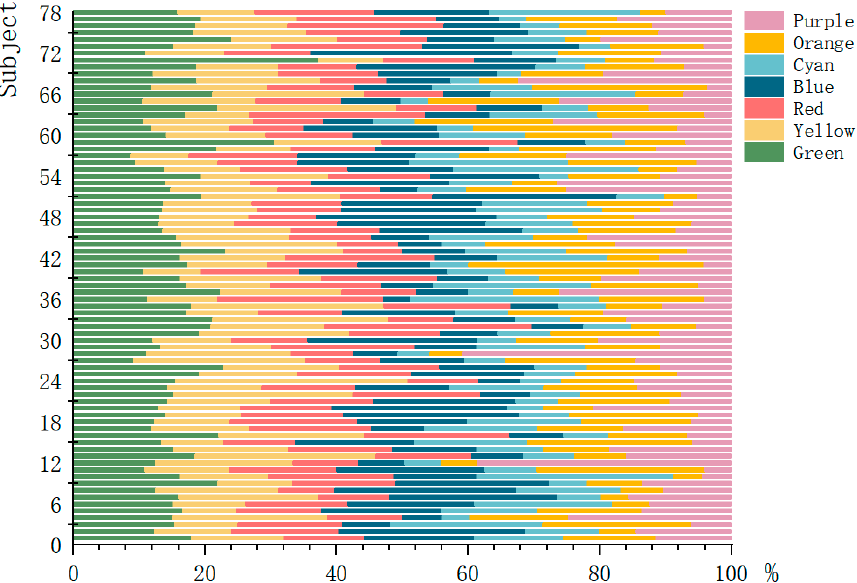
Figure 7. The changing trend of degree of interest of the 78 subjects. Source: ErgoLAB platform was used to export the data, and the overall interest of each subject in the immersive experience was classified as 100%. The figure reflects the proportion of interest of 78 subjects in seven types of landscape colours.